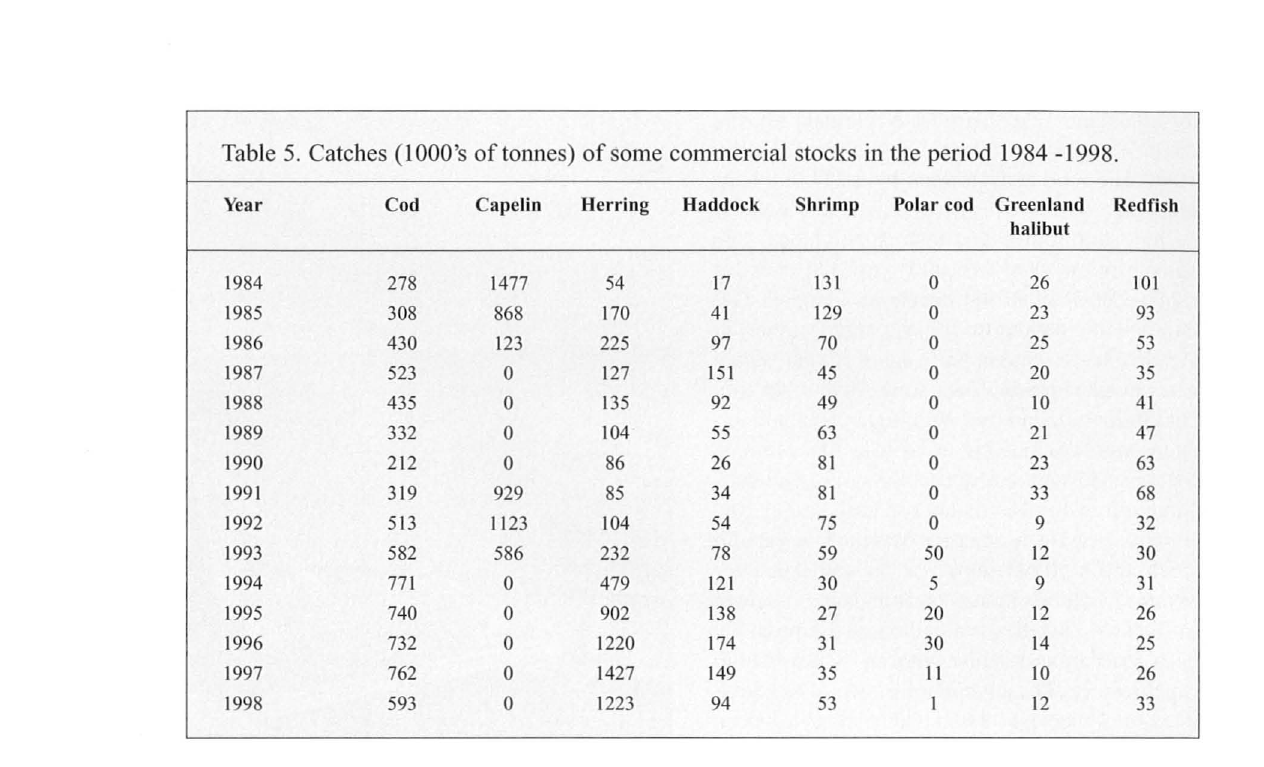
Table 5. Catches (1000's oftonnes) of some commercial stocks in the period 1984